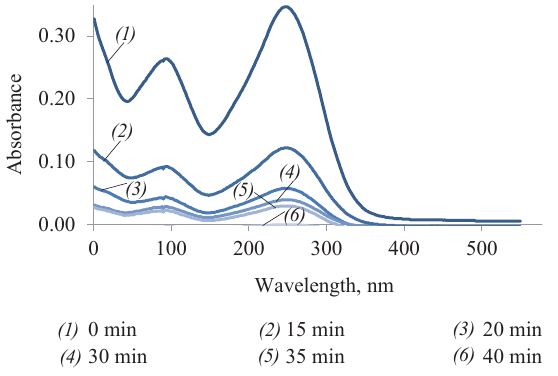
Fig 2: Absorbance of crystal violet at different contact time